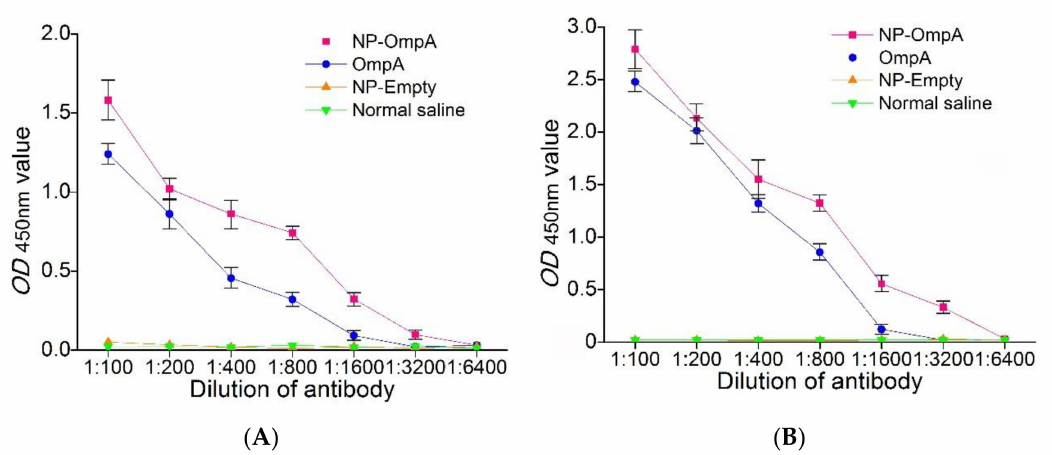
Figure 8. ELISA results showing the interaction between antibodies and Escherichia coli ( A ) and antibody titer ( B ). Panel A shows that antibodies from mice immunized with NP-OmpA interacted with E. coli when the dilution reached 1:1600, and the binding ability of antibodies from mice immunized with NP-OmpA to E. coli was greater than that of antibody from other groups in vitro. Panel B shows that antibodies from mice immunized NP-OmpA bound to OmpA at a dilution of 1:3200 were at a higher titer than other